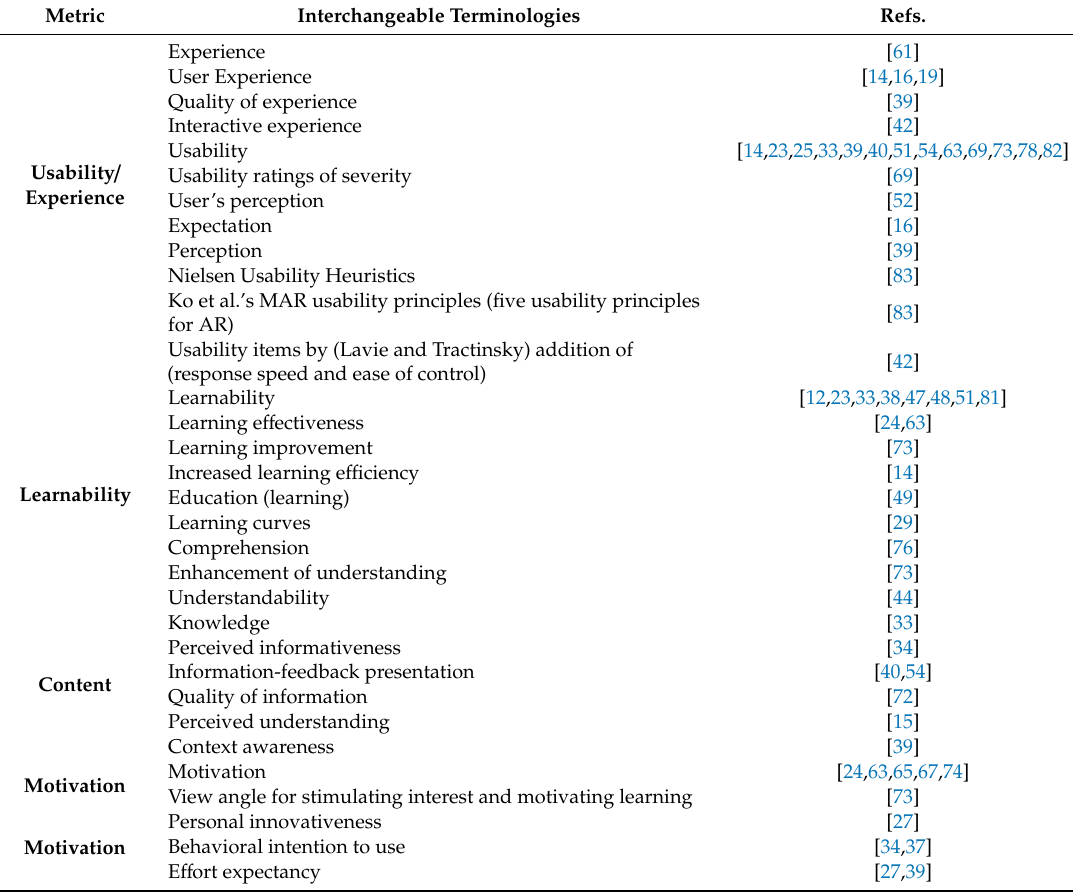
Figure 4. Groups of usability metrics. Table 11. Usability metrics and interchangeable terminologies used by selected studies.